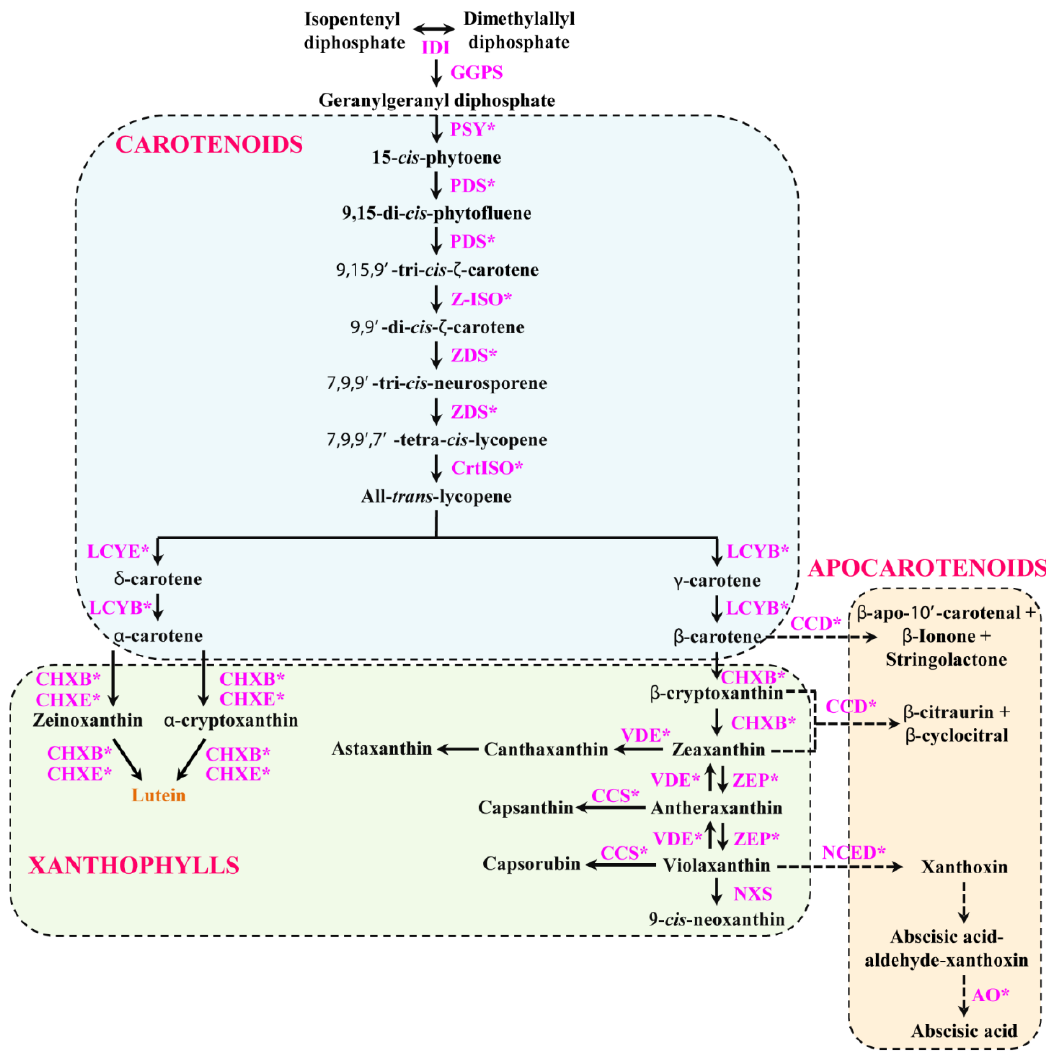
Figure 1. Proposed CBP, XBP, and ABP in Chelidonium majus . Enzymes are shown in pink. Asterisk denotes the gene used for identification, characterization, and gene expression studies. Solid black arrows represent biosynthesis and dotted black arrows represent the degradation of carotenoids.